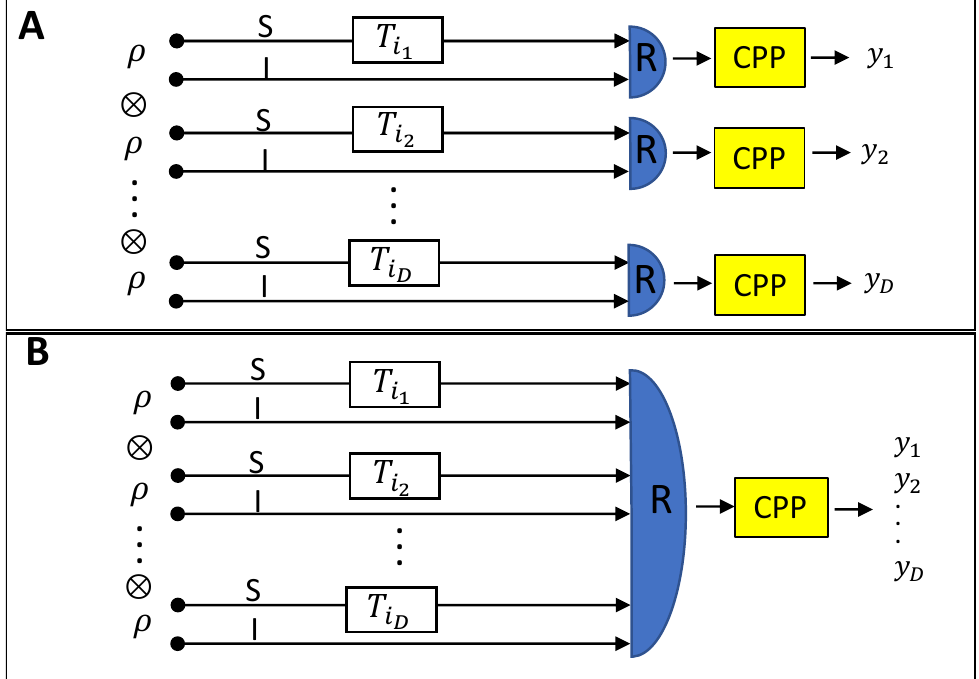
Figure 1. Memory readout scheme. ( A ) Local readout. A memory is depicted by an array of D cells, each represented by the transmittance T i , i = 0,1. T i is in general a random variable, but in the case of a perfect cell it reduces to a single parameter τ i . A bipartite state ρ is irradiated by a transmitter. The signal (S) system interacts with the memory cell while the idler (I) is sent directly to a local receiver ( R ) where it is measured jointly with the signal. The value of the bit is determined by classical post-processing (CPP) of the measurement result. ( B ) Global readout. If an array of length D (a memory) is tested in parallel, instead of cell by cell, D copies of ρ are sent to the cells, one for each, and a joint measurement between all the copies is